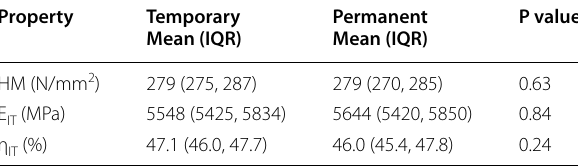
IQR, interquartile range